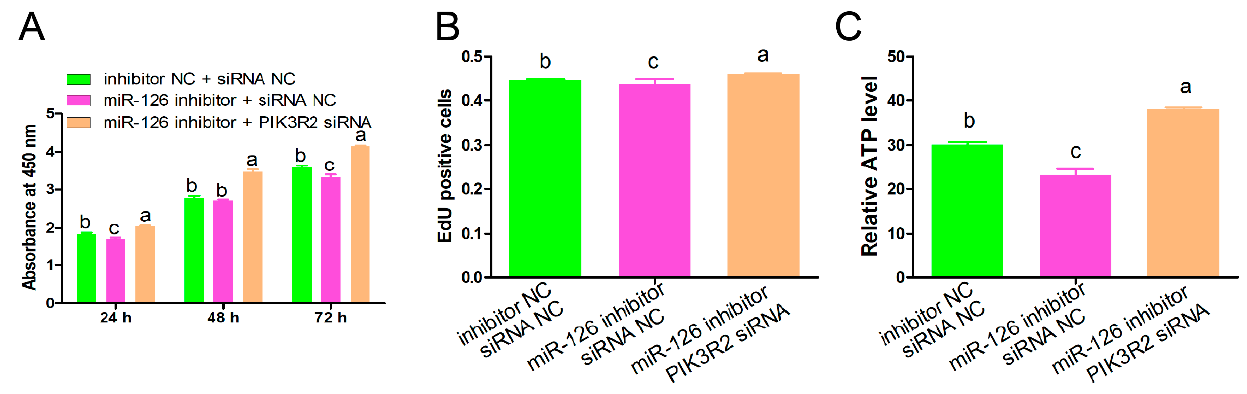
Figure 6. PIK3R2 knockdown abolishes the effects of miR-126 overexpression. Three co-transfection treatments were conducted in this section, including inhibitor NC + siRNA NC, miR-126 inhibitor + siRNA NC, and miR-126 inhibitor + PIK3R2 siRNA. ( A ) The effects on cell proliferation were measured using the CCK-8 assay. The absorbance value of each well was detected using an ELISA plate reader (Molecular Devices, USA) at 450 nm ( n = 3). ( B ) The cell mitotic activity was measured using the EdU incorporation assay ( n = 3). Representative images of EdU staining of immature porcine Sertoli cells 24 h after transfection. Scale bar = 200 µ m. ( C ) The relative ATP levels were measured by an ELISA assay. Data are presented as mean ± SEM. Different letters indicate that values within each section were significantly